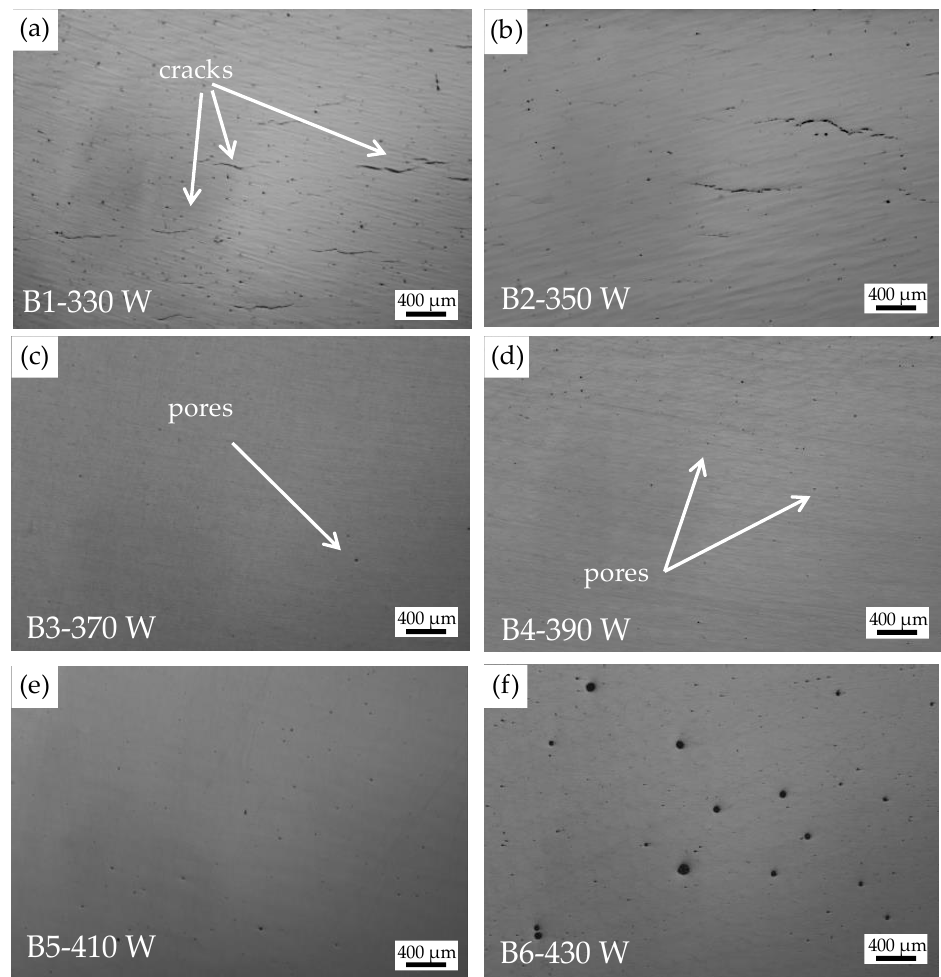
Figure 6. Metallographic photographs of formed samples at different P: ( a ) 330 W, ( b ) 350 W, ( c ) 370 W, ( d ) 390 W, ( e ) 410 W, ( f ) 430 W.